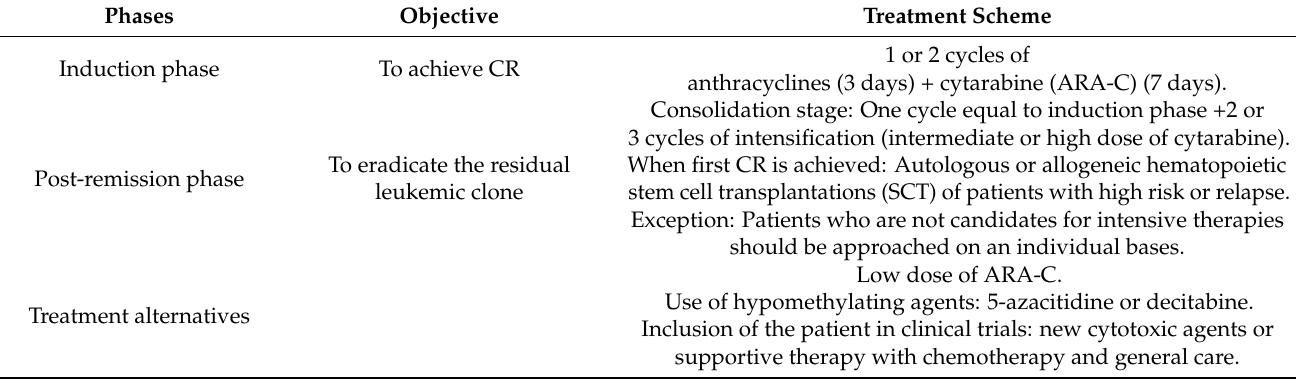
Table 2. Acute Myeloid Leukemia standard regimen